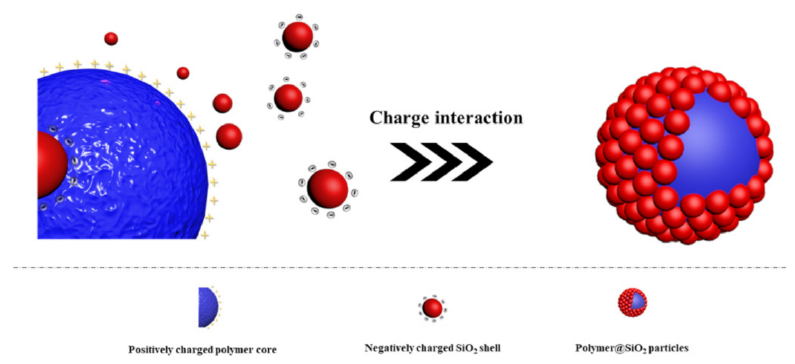
Figure 6. Schematic diagram of the charge